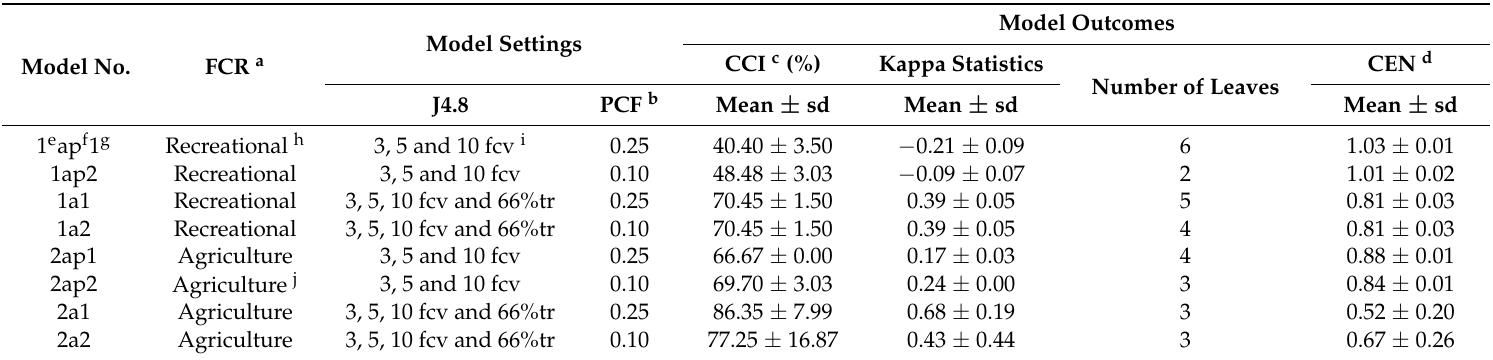
Table 3. Predictive results from models developed during the models development phase that were based on the J4.8 algorithm pruned tree (before optimization): correctly classified instances (CCI), Kappa statistics and overall confusion entropy of a confusion matrix (CEN).